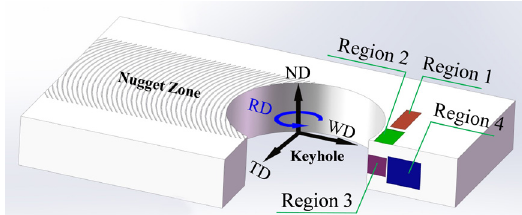
Figure 2. Welding direction and rotation direction of the shoulder and sample location diagram of EBSD maps.